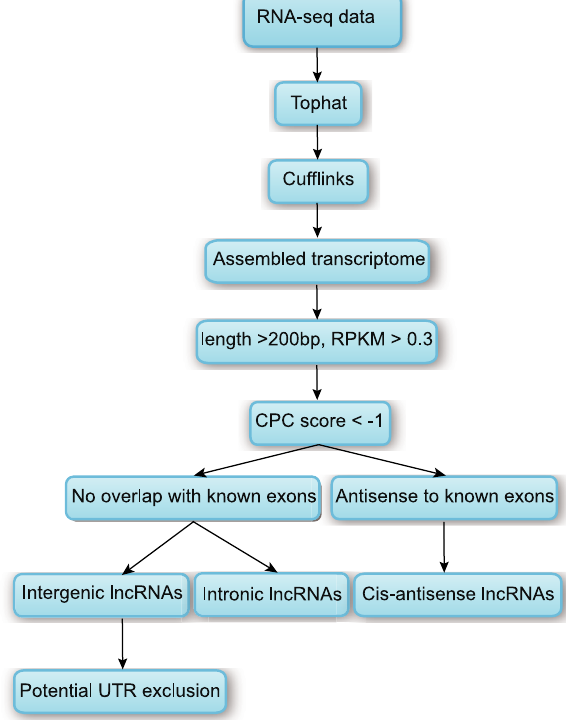
Figure 1. Pipeline for identification of lncRNA. Refer to main text for details.